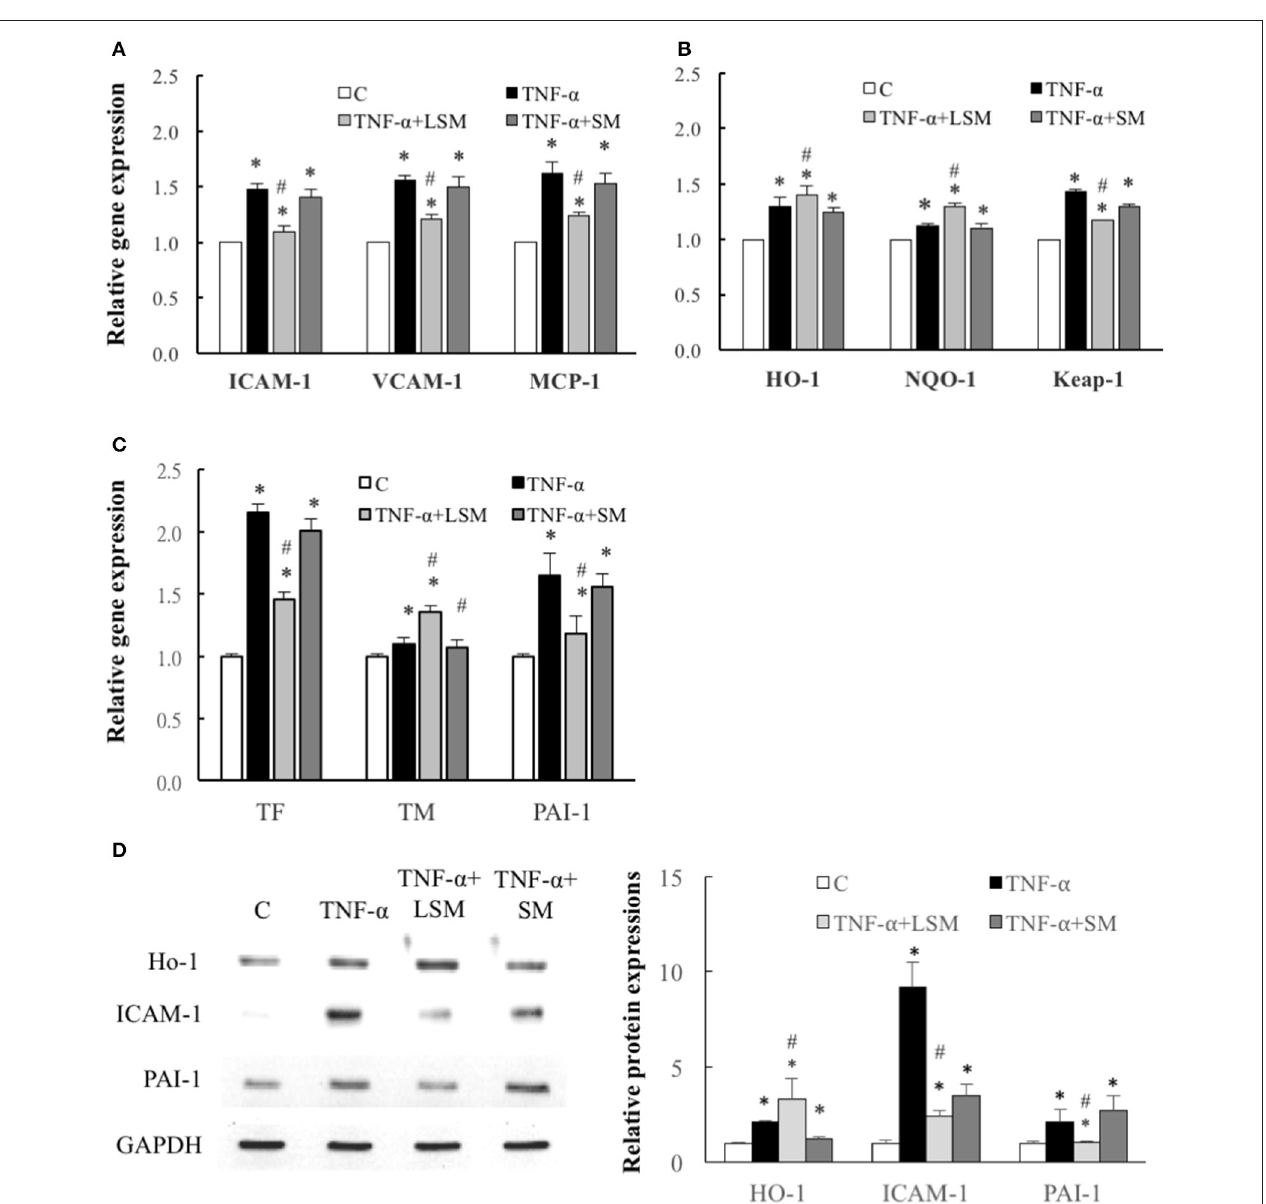
FIGURE 3 | Determination of inflammation, ROS induction, and thrombosis-related gene and protein expression. Expression of (A) inflammation - related ICAM-1 , VCAM-1 , and MCP-1 genes, (B) ROS induction–related HO-1 , NQO-1 , and Keap-1 genes and (C) thrombosis-related TF , TM , and PAI-1 genes were all significantly increased in the TNF- α group compared to in the control group. Gene expression levels of ICAM-1 , V-CAM-1 , MCP-1 , Keap-1 , TF , and PAI-1 were attenuated significantly by LSM treatment compared to those in the TNF- α group, but similar trends were not observed in the TNF- α + SM group. However, gene expression of HO-1 , NQO-1 , and TM were significantly enhanced by LSM treatment compared to those in the TNF- α group, but similar trends were not observed in the TNF- α + SM group. (A–C) Data are expressed as the mean ± S.E.M. ( n = 3). * p < 0.05 indicates a significant difference relative to the control group. # p < 0.05 indicates a significant up- or downregulation, relative to the individual TNF- α group (excluding all control groups). (D) Compared with those in the control group, the protein levels of HO-1, ICAM-1, and PAI-1 were increased significantly in the TNF- α group. The expressions levels of the antioxidant protein HO-1 increased significantly in the TNF- α + LSM group compared to those in the TNF- α group. ICAM-1 and PAI-1 protein expression were attenuated significantly in the TNF- α + LSM group compared to those in the TNF- α group ( n = 3). SM, static medium; LSM, new laminar shear medium. * p < 0.05 indicates a significant difference relative to the control group. #p < 0.05 indicates a significant up- or downregulation relative to the individual TNF- α group.